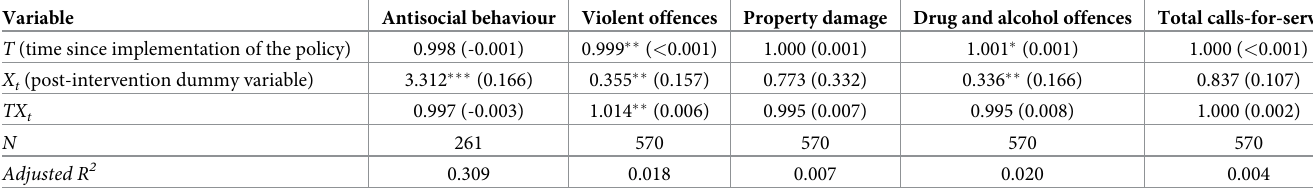
Table 2. Interrupted time series analysis results. Antisocial behaviour Violent offences Property